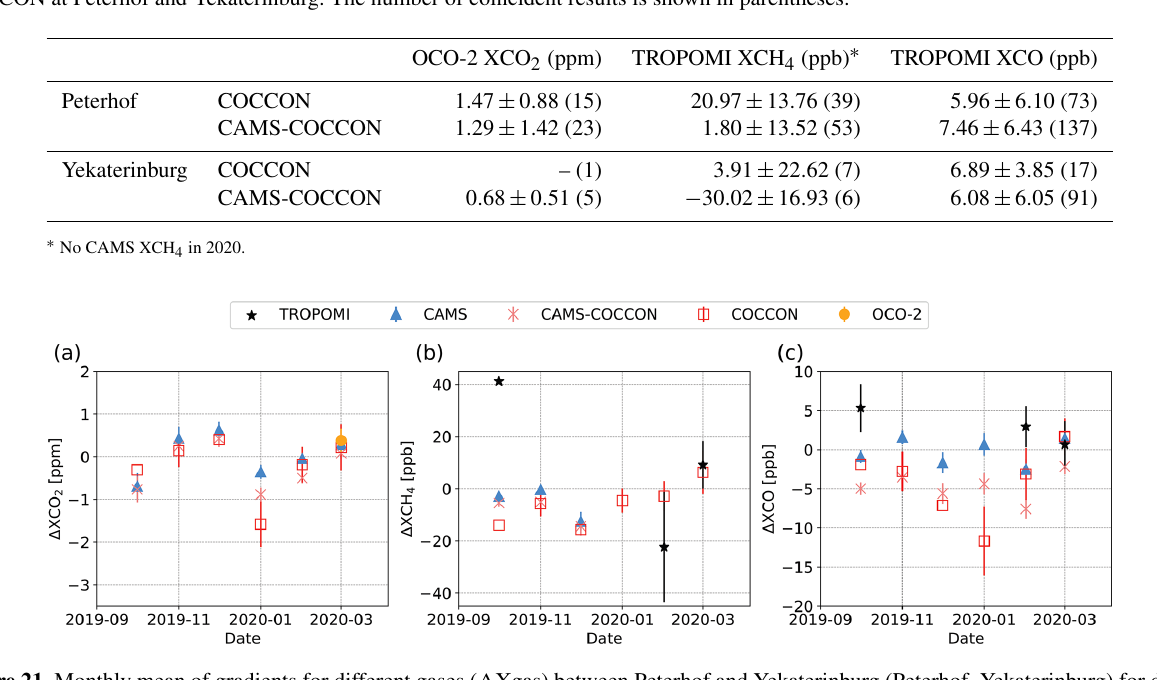
Table 4. Selected averaged bias and standard deviation between satellite products and COCCON and between satellite products and CAMS- COCCON at Peterhof and Yekaterinburg. The number of coincident results is shown in parentheses.